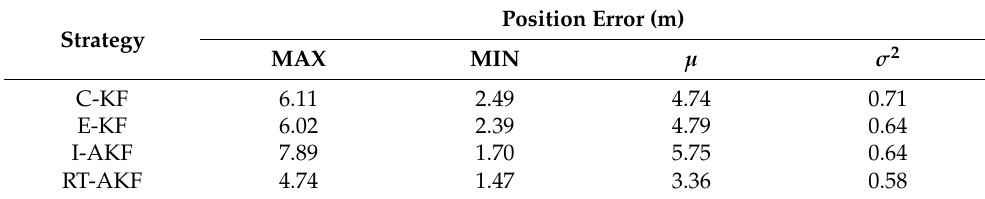
Table 8. Position Error Comparison Using Different Algorithm in Segment #6.